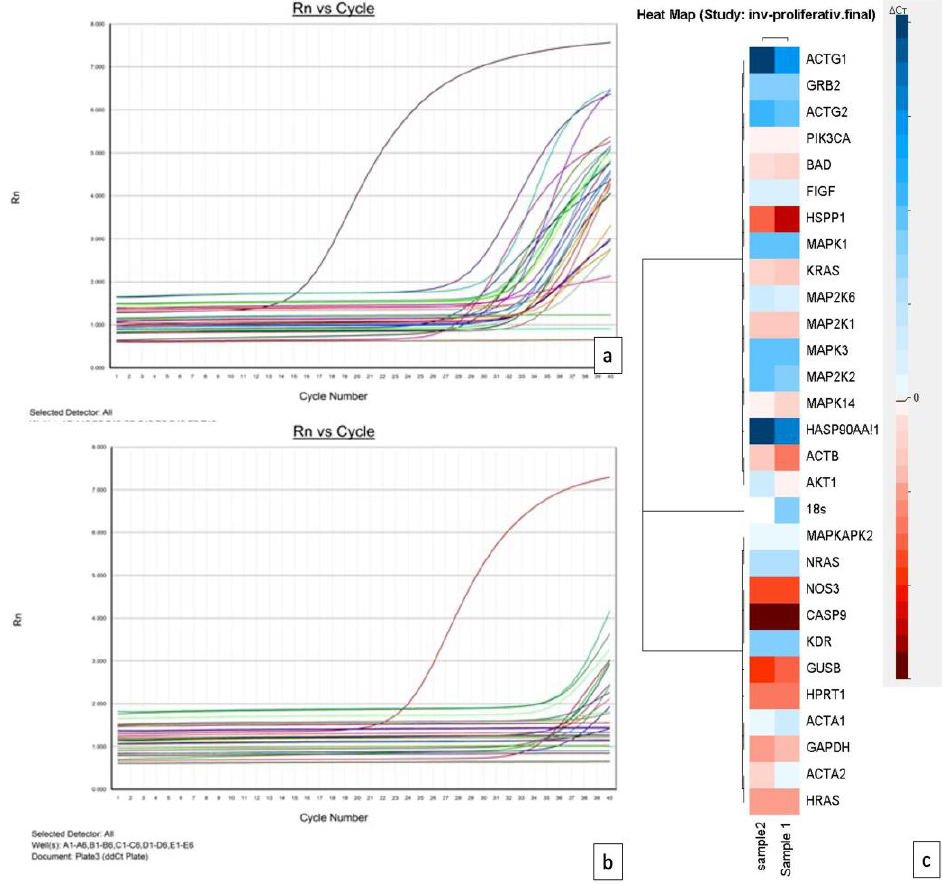
Figure 3. Amplification plots from proliferating ( a ) and involuting ( b ) hemangiomas and a comparative heatmap ( c ) generated using Data Assist software based on RT PCR VEGF pathway gene expression profile assessment.